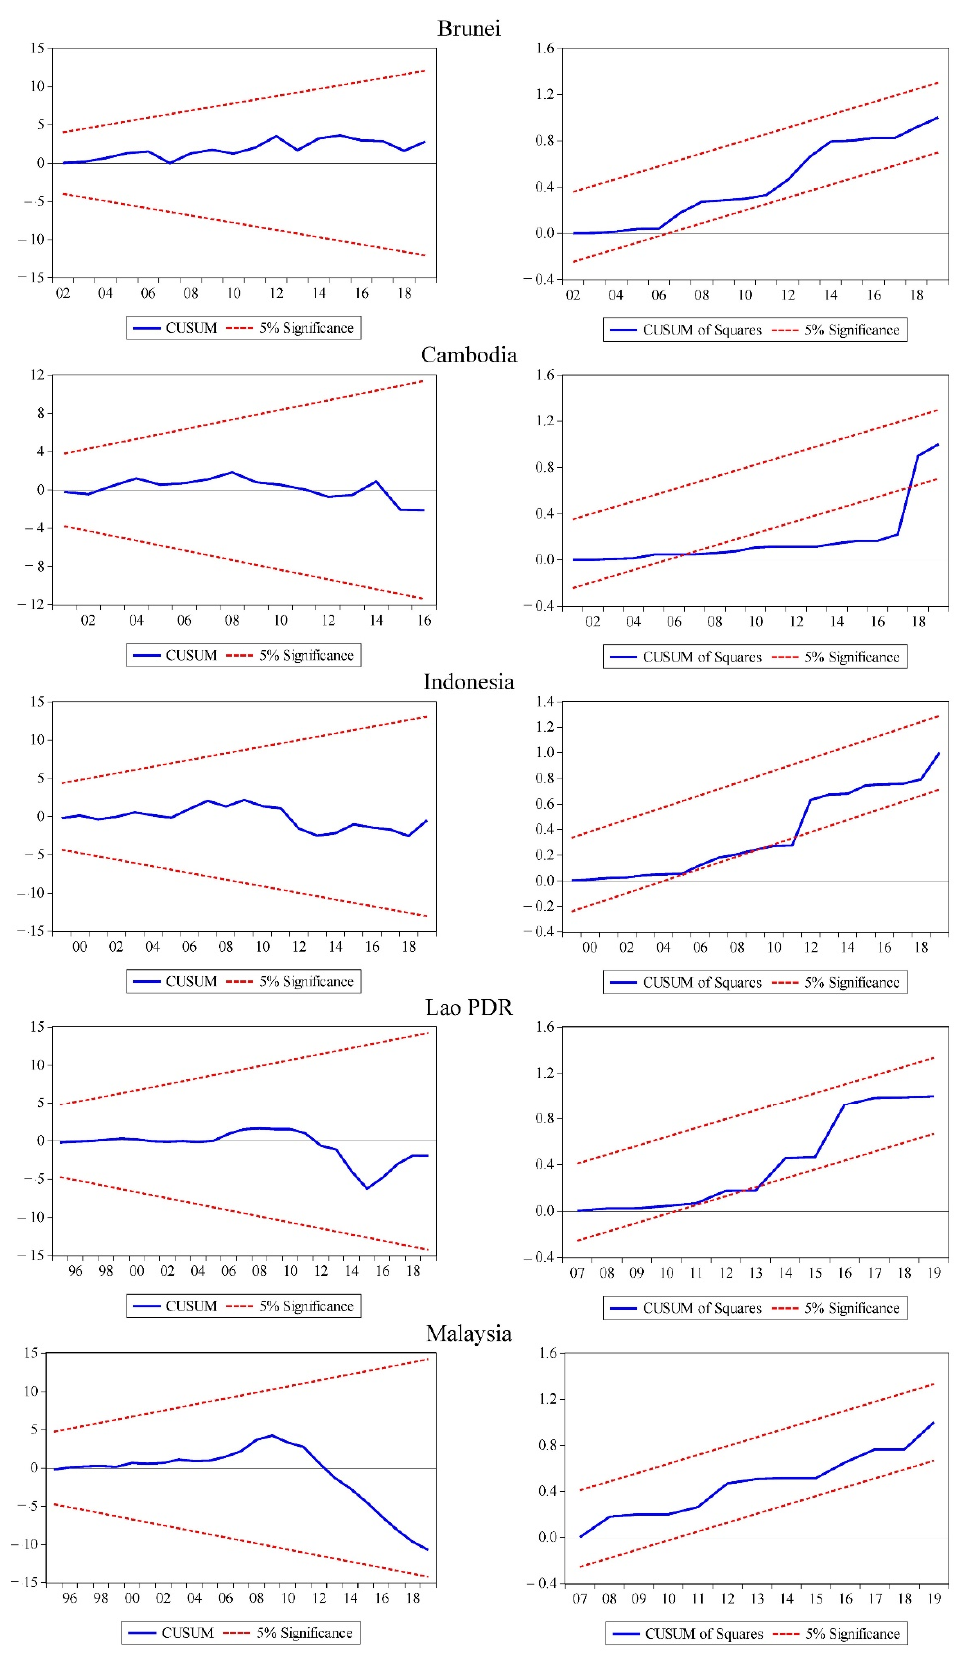
Figure 6. Findings of stability test (structural breaks and coefficient stability test) .